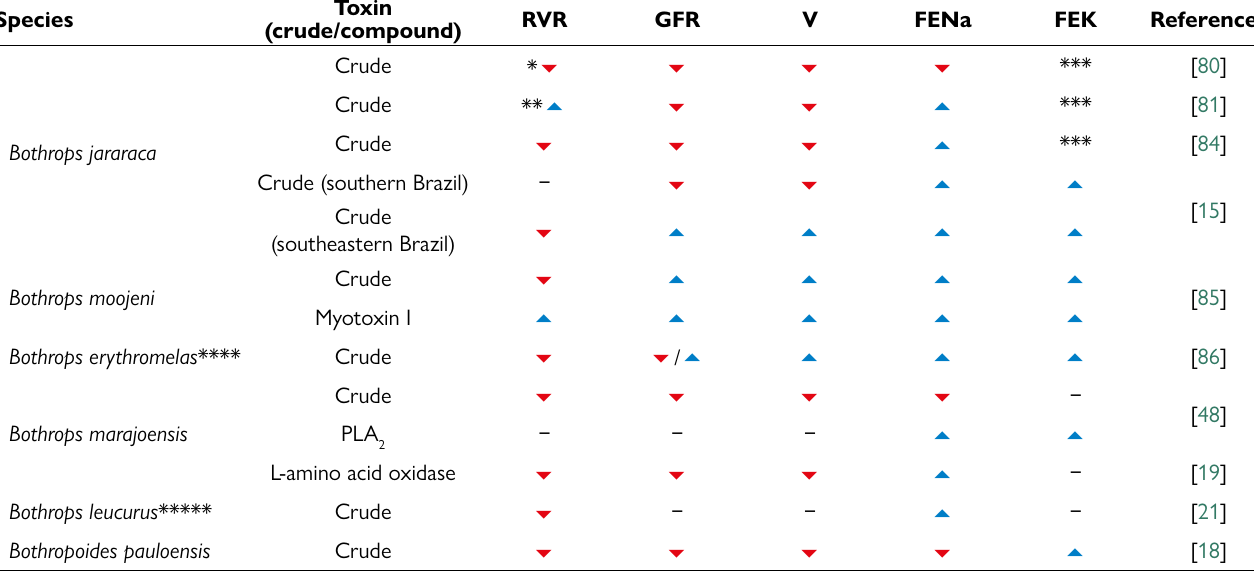
RVR: renal vascular resistance; GFR: glomerular filtration rate; V: urinary flow; FENa: fractional excretion of sodium; FEK: fractional excretion of potassium; FECl: fractional excretion of chloride. *  Decrease. **  Increase. ***Not determined. ****GFR decreased at 60 min and increased at 120 min. *****The effect on urinary flow and GFR was transient and returned to normal at 120min of venom perfusion. (−) No